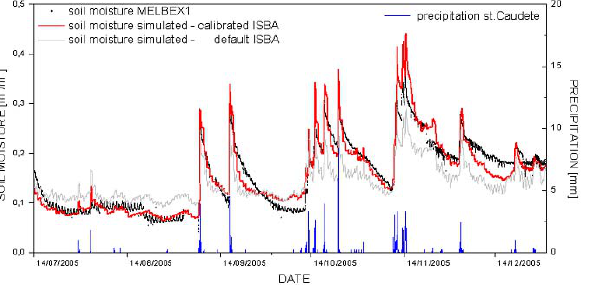
Fig. 4. Comparison between observed (black line) and simulated soil moisture using the default ISBA (clear grey line) and the cali- brated ISBA (red line) at 5cm depth. The precipitation correspond- ing to the meteorological station Caudete de las Fuentes are repre- sented in